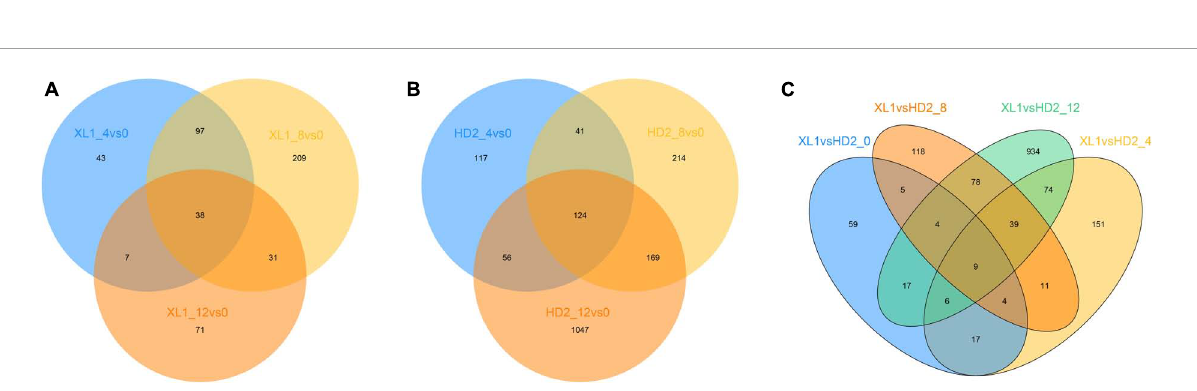
FIGURE2 The venn diagram of differentially expressed genes (DEGs). (A) DEGs response to drought stress in XL1, (B) DEGs response to drought stress in HD2, (C) DEGs between XL1 and HD2 during drought